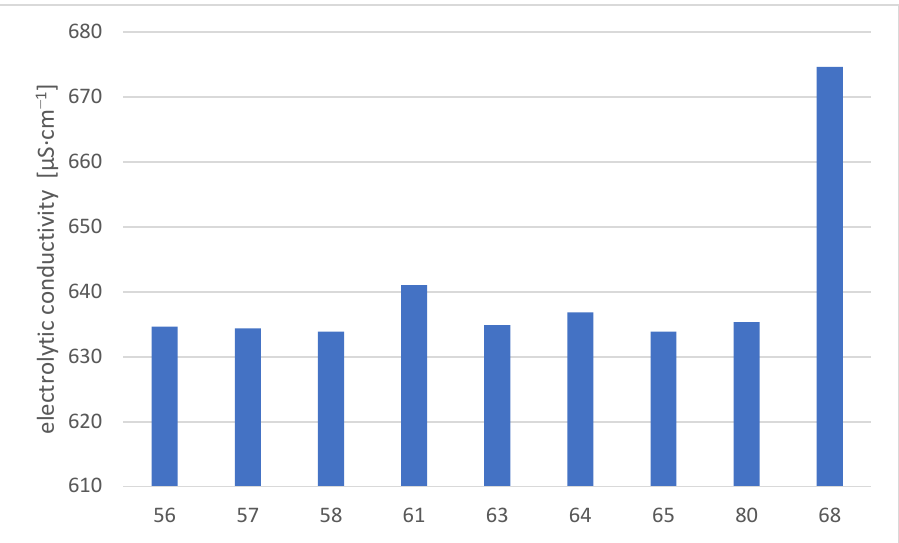
Figure 4. Variation of the annual average conductivity in measurement points in the water of Lake Swarz ę dzkie and Cybina river.